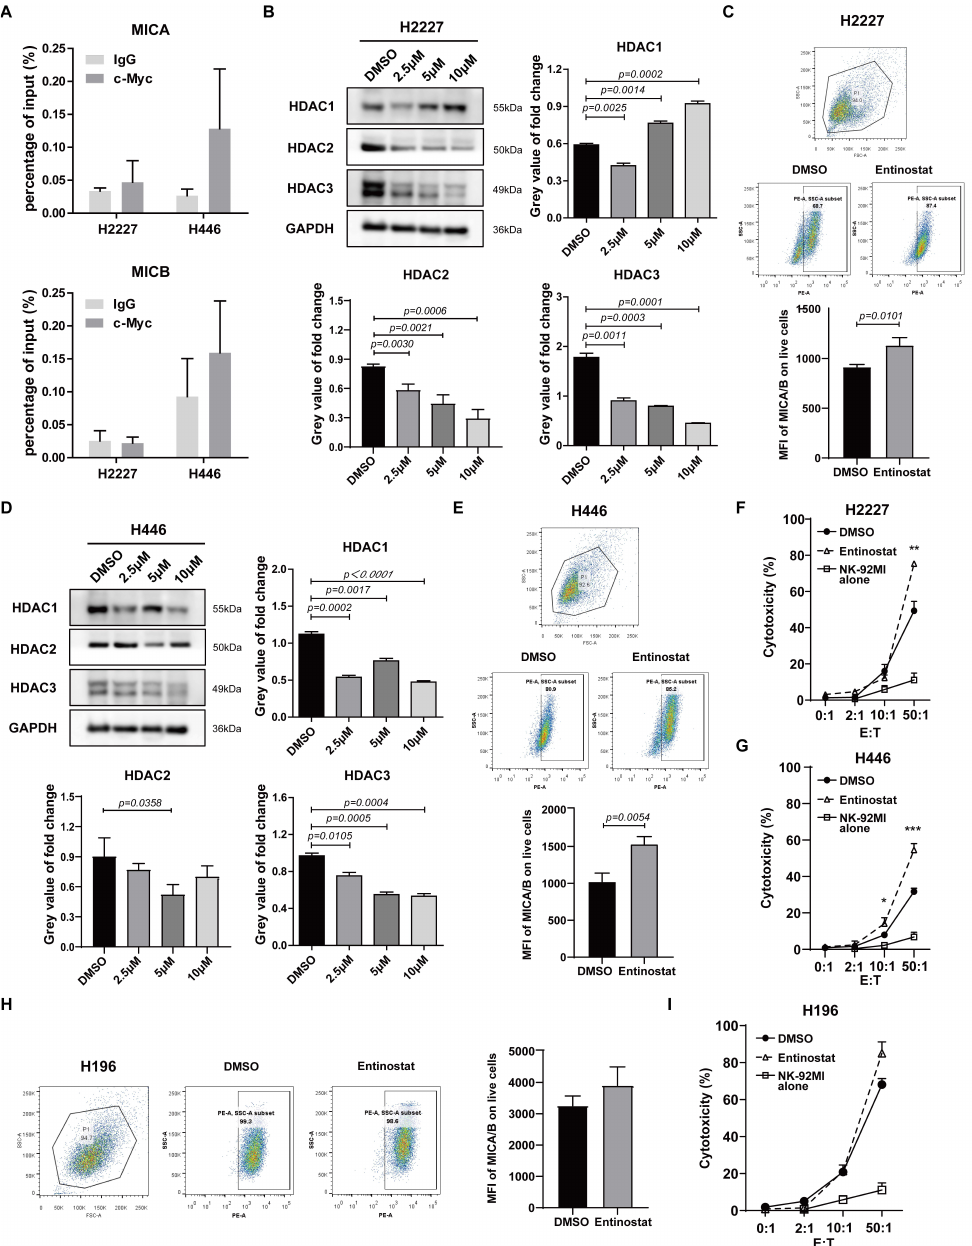
Figure 3. HDAC inhibitor modulated NKG2DL expression and susceptibility to NK cell killing of SCLC-N cells. ( A ) ChIP-qPCR analysis of c-Myc enrichment at MICA and MICB promoters in H2227 and H446 cells. ( B , D ) Western blotting analysis of HDAC1, HDAC2, and HDAC3 in H2227 and H446 cells treated with or without Entinostat (2.5 µ M, 5 µ M, and 10 µ M). ( C , E , H ) Flow cytometry analysis of MICA/B expression levels on H2227, H446, and H196 cells treated with or without Entinostat (10 µ M). ( F , G , I ) LDH analysis of the susceptibility to NK-92MI cell killing of H2227, H446, and H196 cells treated with or without Entinostat (10 µ M). Data are represented as mean ± SD ( n = 3). * p < 0.05, ** p < 0.01, *** p < 0.001 vs. DMSO